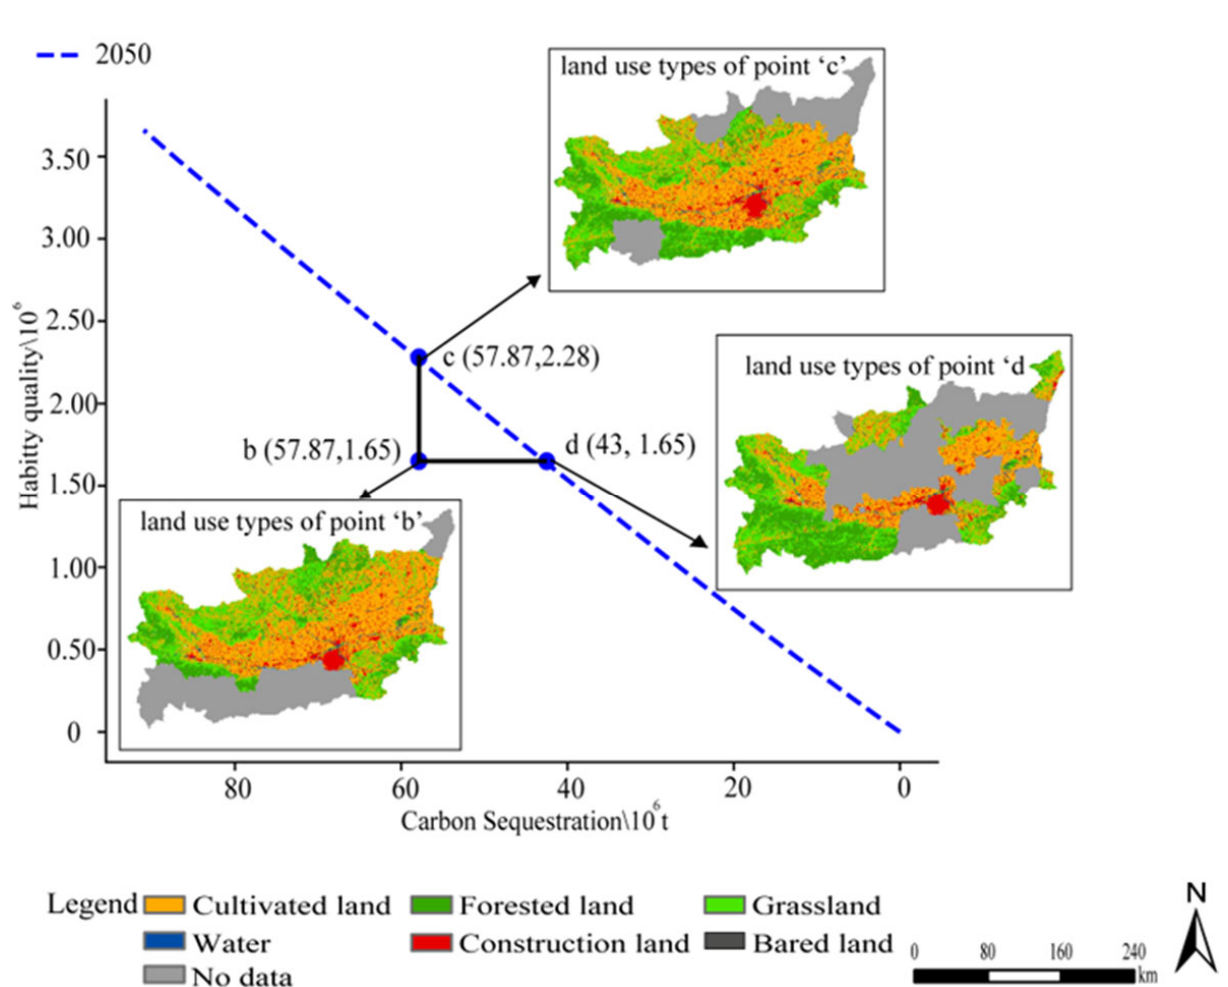
Figure 6. Land use pattern under optimal PPF curves between habitat quality and carbon seques ‐ tration.